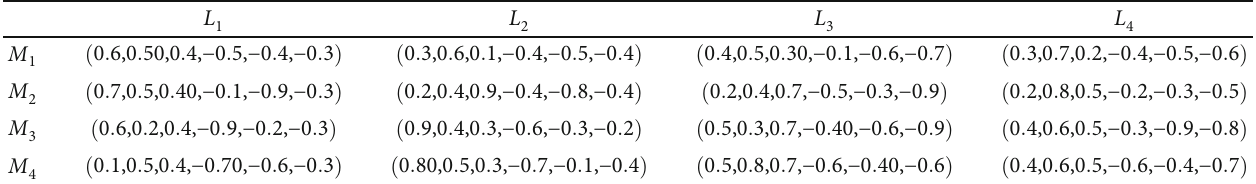
Table 2: BNN decision matrix D